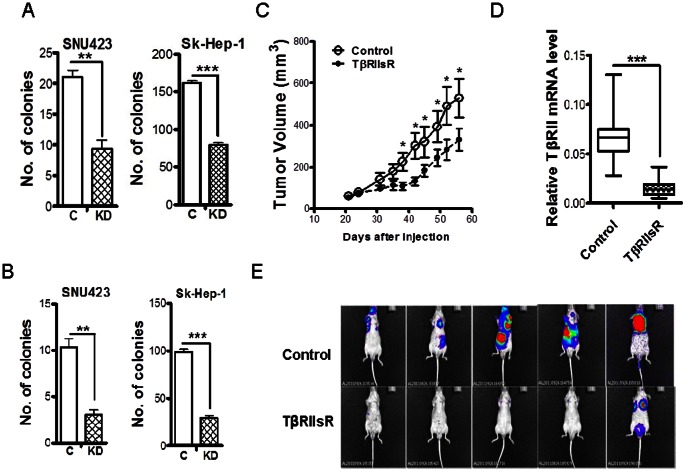
Reduced tumorigenic and metastatic ability in vitro and in vivo of SNU423 and Sk-Hep-1 cells by the knockdown of TβRII.
Soft-agar (A) or hard-agar (B) colony formation ability was assessed for SNU423 and Sk-Hep-1 cells with control or TβRII shRNA for 14 days. Colonies were counted after staining. Each data point represents mean±SEM from three independent wells. **, p<0.01; ***, p<0.001. (C) Subcutaneous tumors were generated by Sk-Hep-1/control and Sk-Hep-1/TβRII shRNA cells. Each data point represents mean ±SEM from ten single tumors. *, p<0.05. (D) Reduced expression of TβRII mRNA in subcutaneous tumors formed by the Sk-Hep-1/TβRII shRNA cells was confirmed with quantitative real-time RT-PCR in comparison with that of Sk-Hep-1/control cell formed tumors. Total RNA was extracted from four tumors. ***, p<0.001. (E) Bioluminescence imaging showed reduced metastases incidence in the Sk-Hep-1/TβRII shRNA group in comparison with the control group.